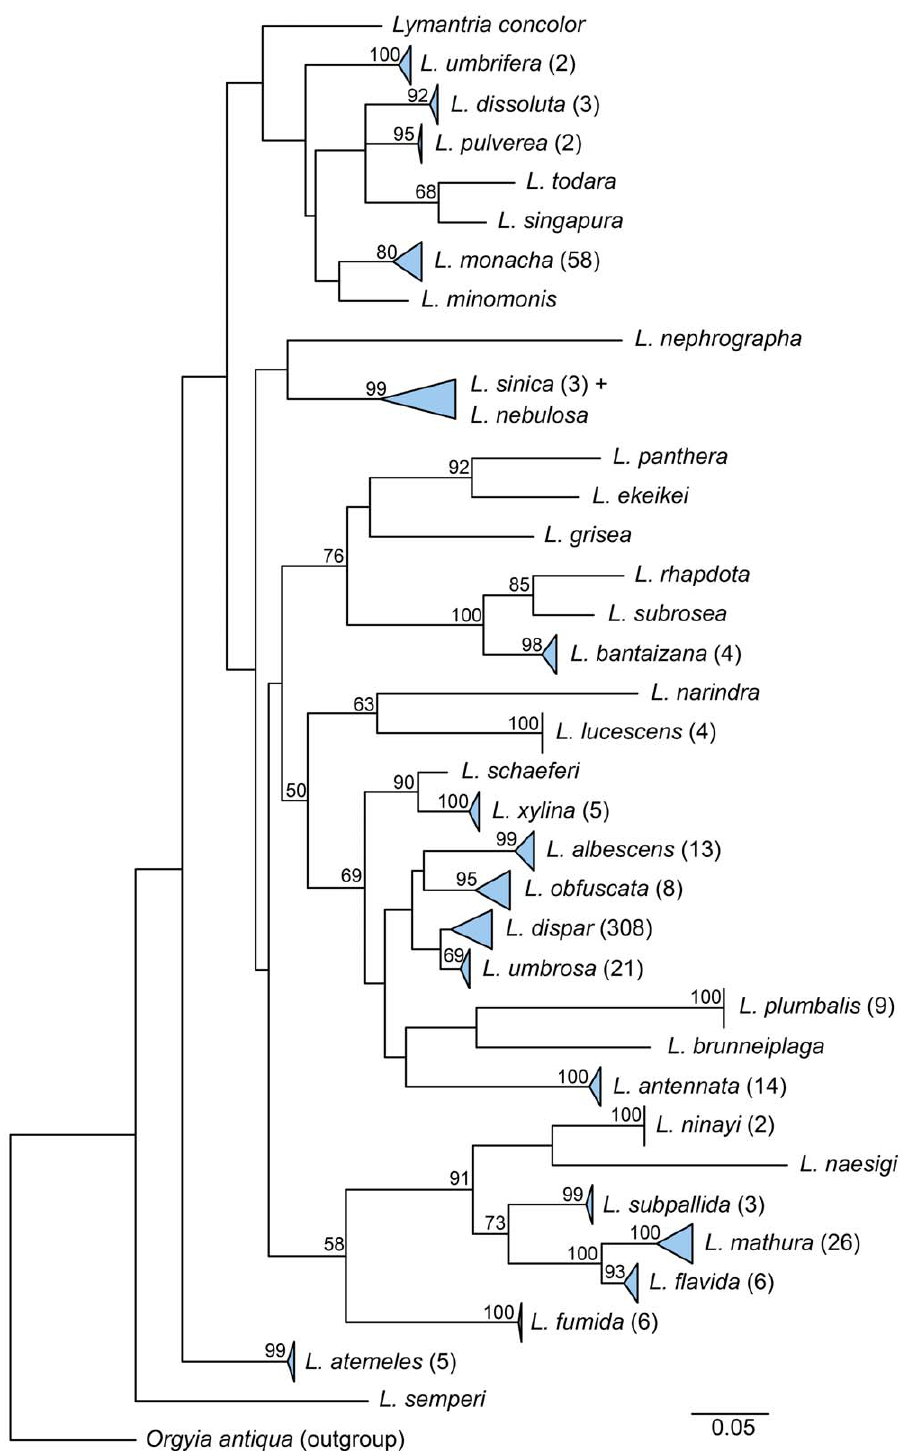
Figure 3. Maximum likelihood tree for 36 species of Lymantria . Tree was constructed with the barcode region of the COI gene for 518 individuals. The number of specimens collapsed into a single node is given in parentheses after the taxon name. Bootstrap support values . 50% are listed above the corresponding node. Width of the triangles represents the sequence divergence within the cluster. Refer to Figure S1 for full tree.